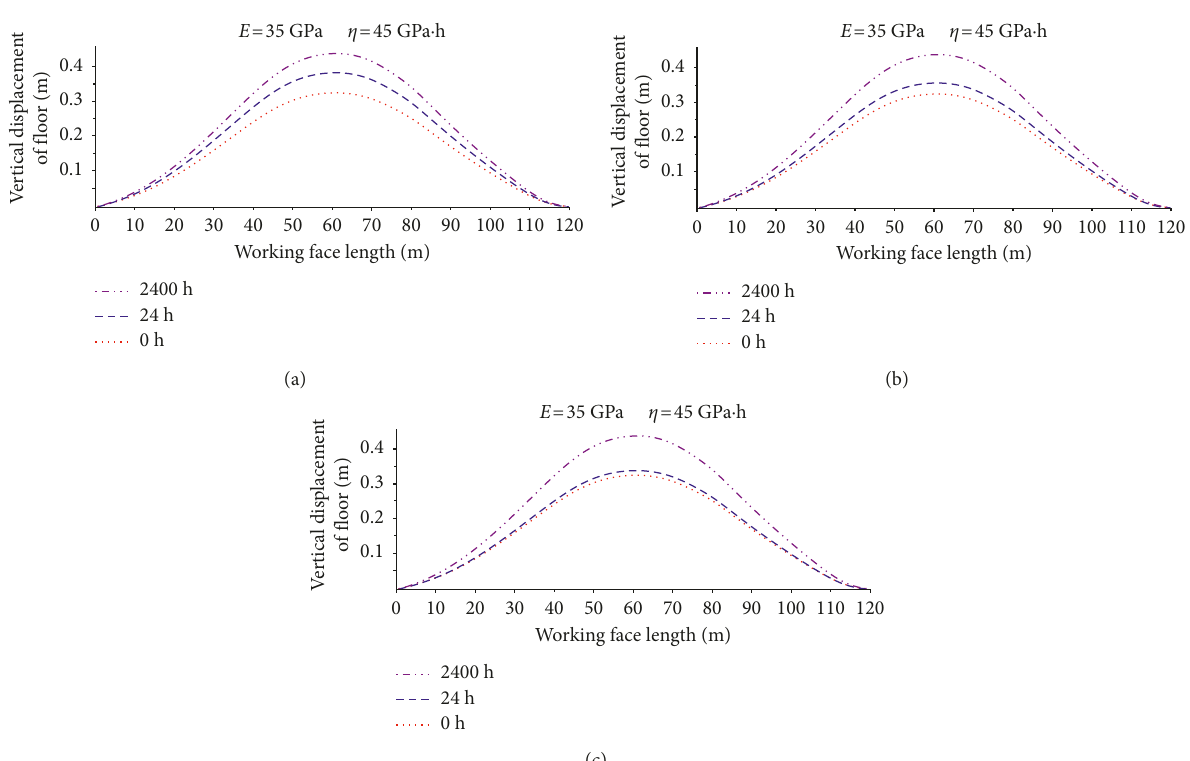
40 GPa h. (b) η 50 GPa h. (c) η 60 GPa h. (cid:29) · (cid:29) · (cid:29) ·